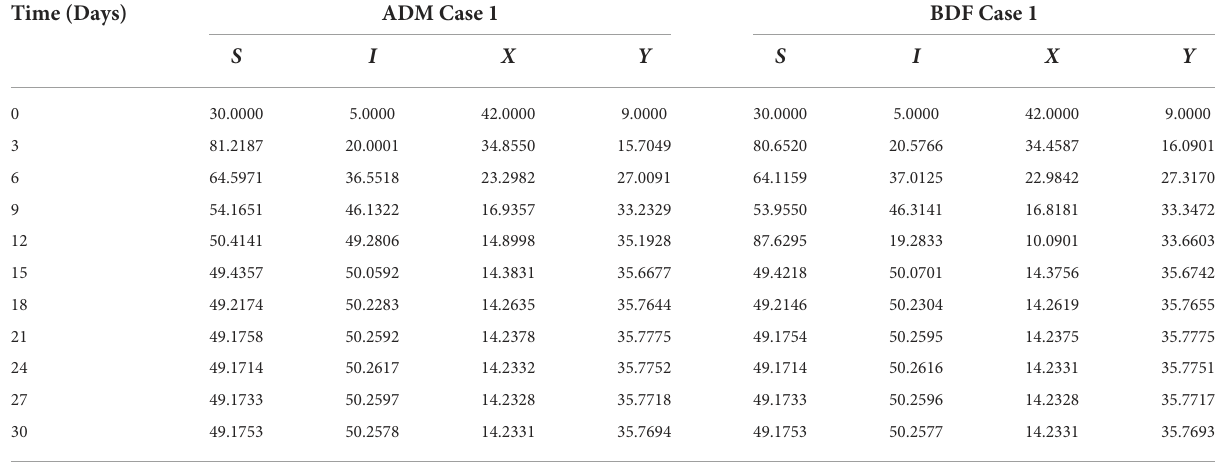
TABLE 6 Numerical outcomes of nonlinear PVPMV model B for case-1 of scenario